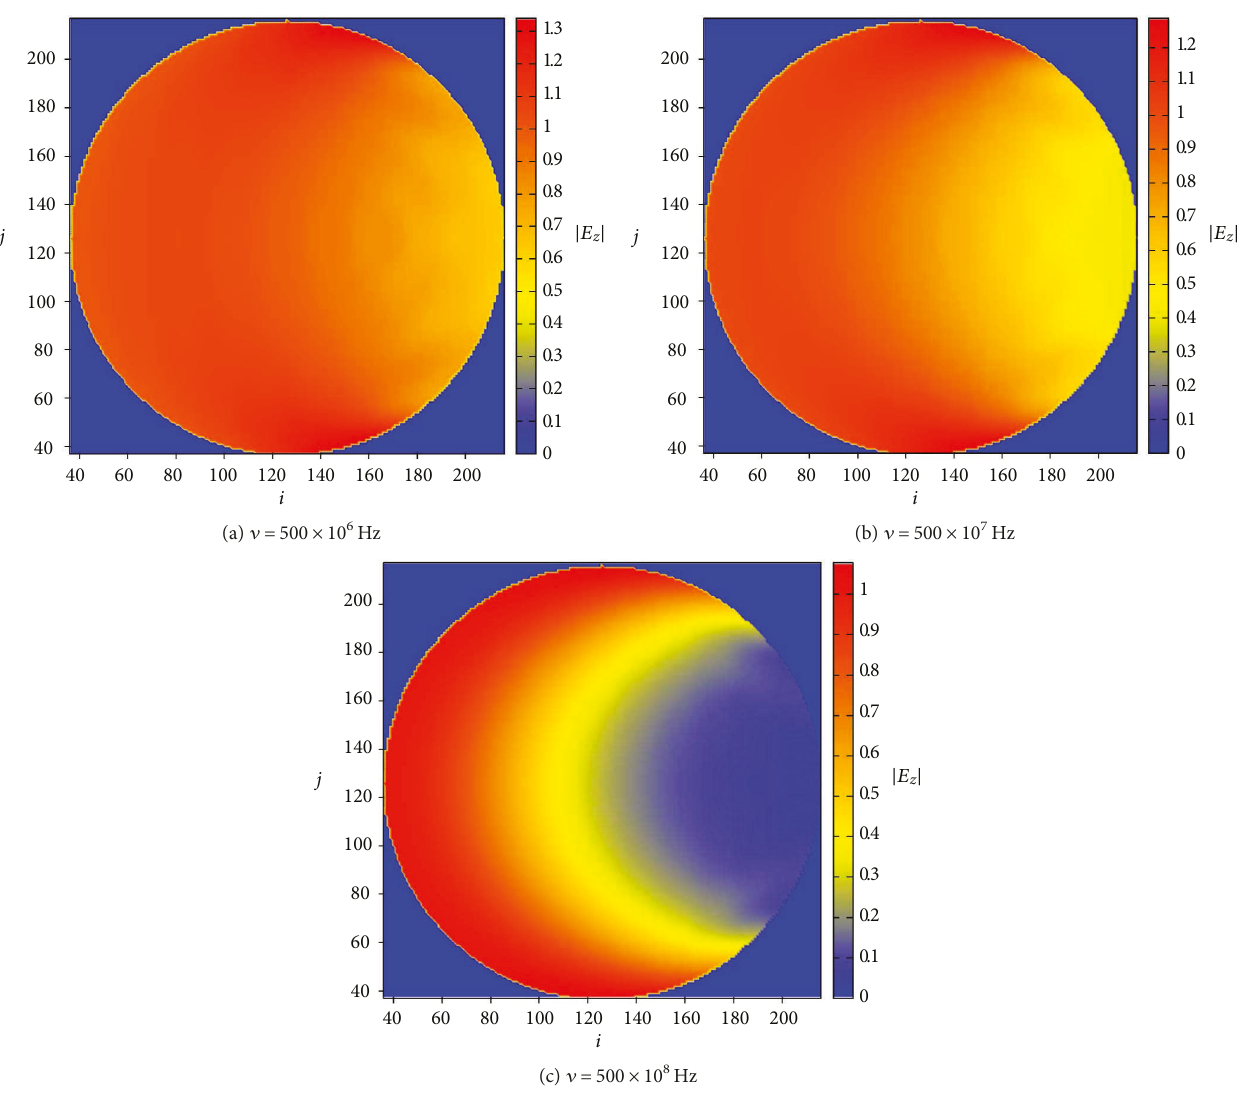
Figure 16: Magnitude of the electric fi eld, in volts/meter, within the inhomogeneous plasma cylinder obtained by the FDTD simulation for di ff erent collision frequencies ν . Incident wave frequency is set to f